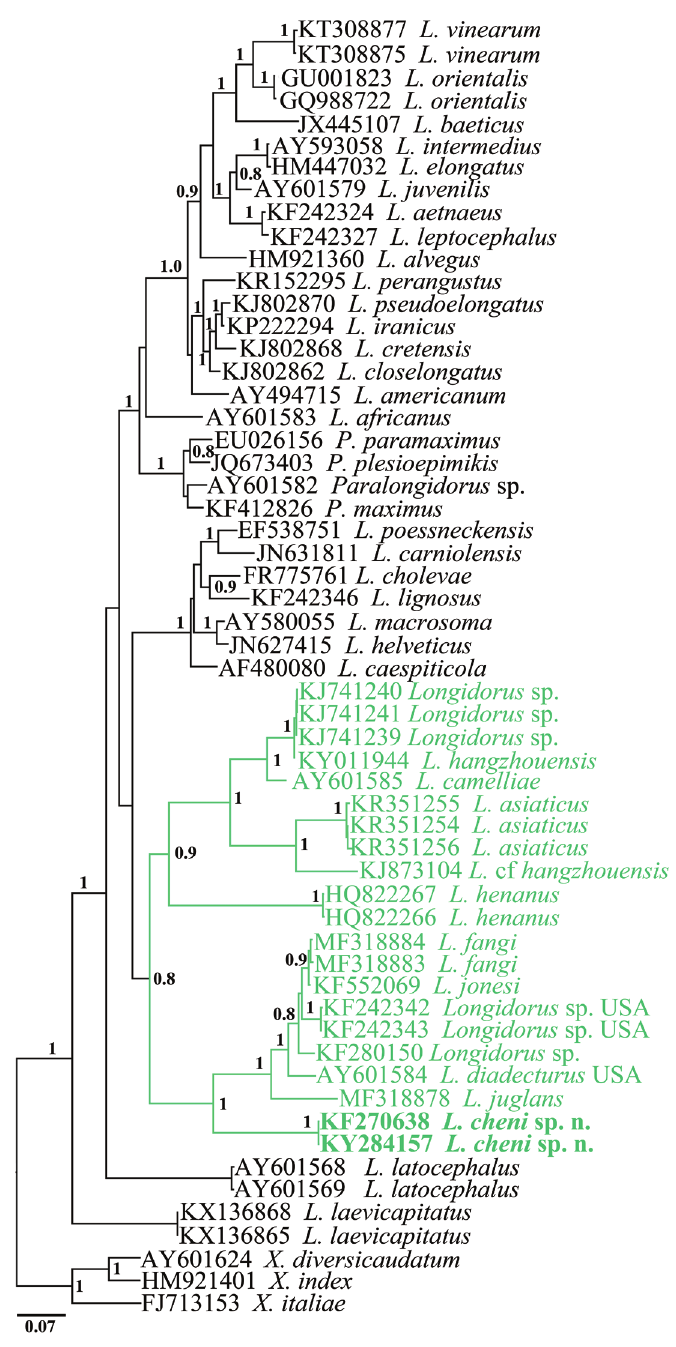
Figure 7. Phylogenetic tree using D2–D3 28S rDNA and inferred from a Bayesian analysis with GTR+G model and Xiphinema spp. as an outgroup. Posterior probabilities ≥ than 0.8 are